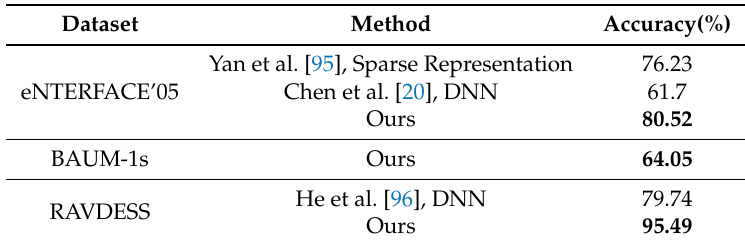
Table 2. The performance comparison of visual emotion recognition with previous works on the eNTERFACE’05, BAUM-1s, and RAVDESS